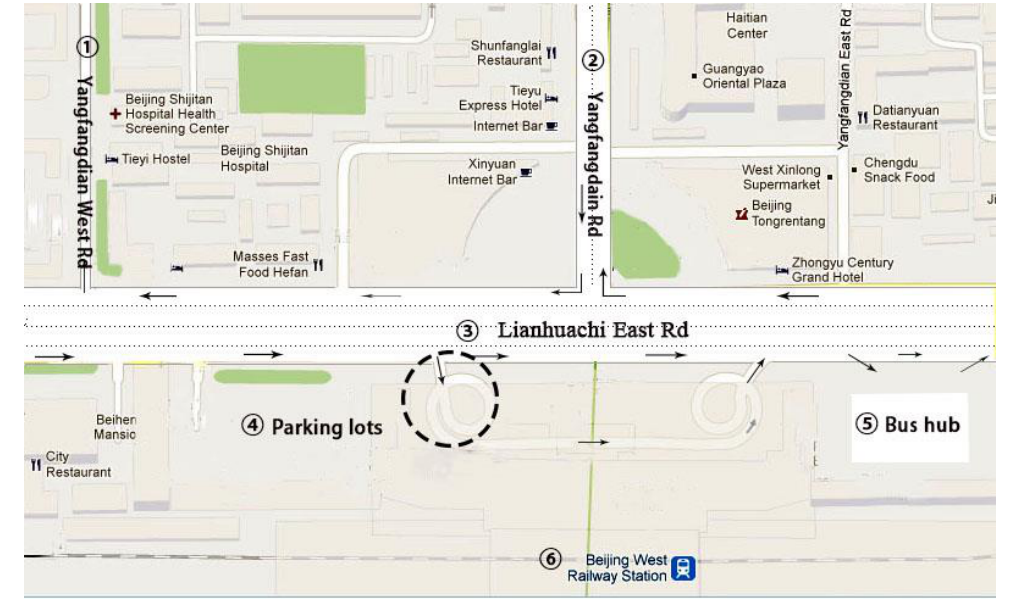
Figure 2. the 1st Congestion Point on Linhuachi East Rd.